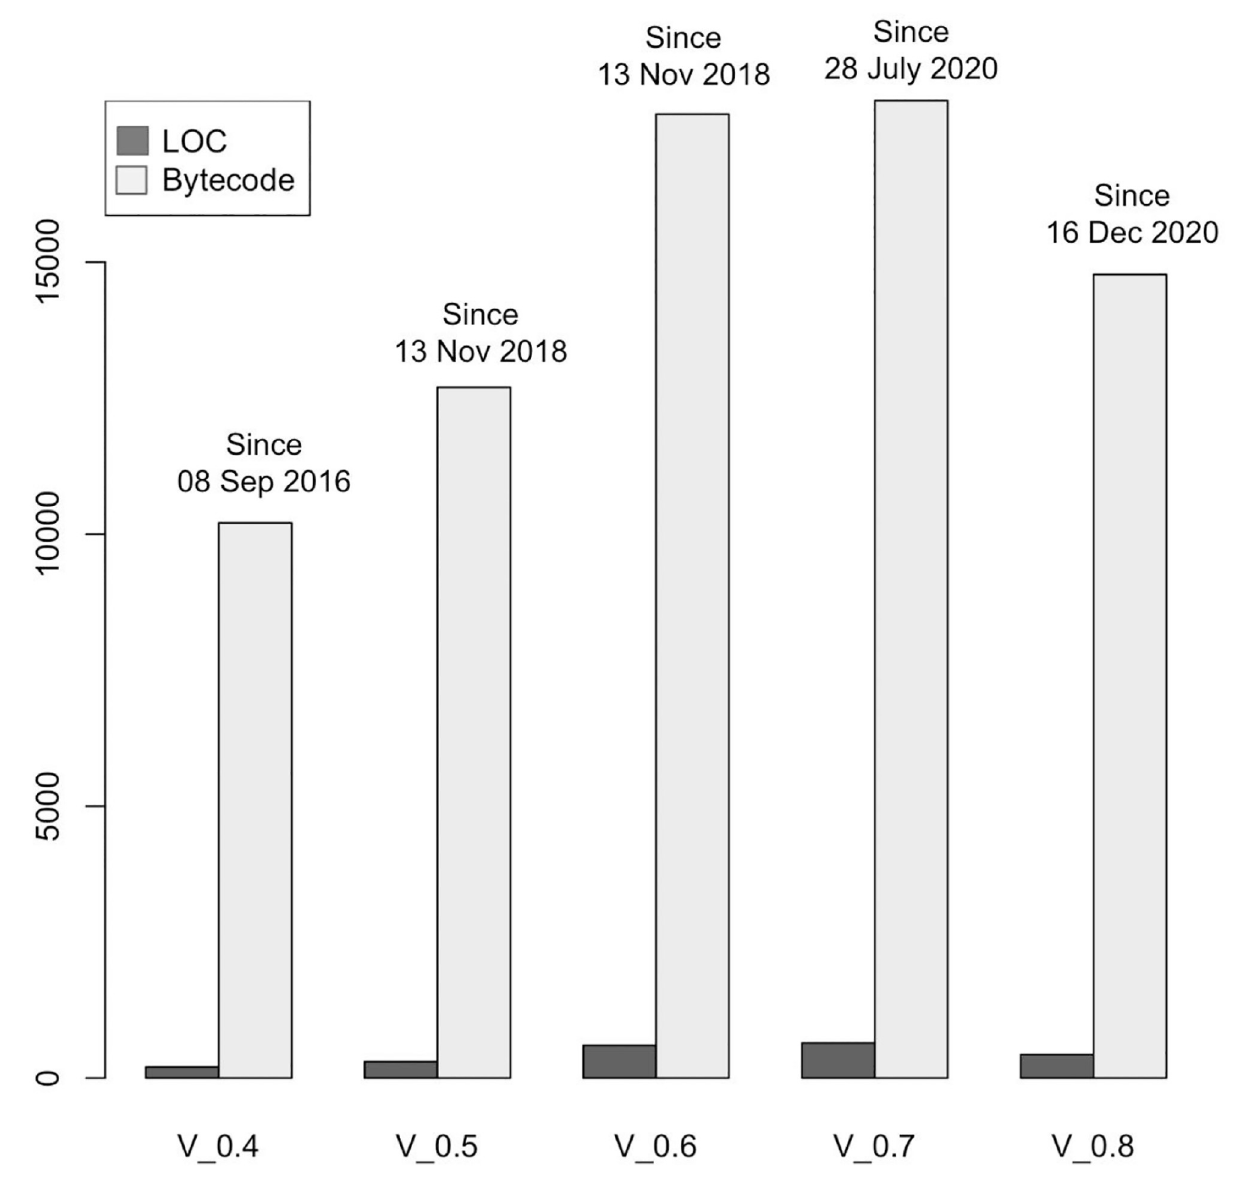
Fig 7. The average number of LOC and Bytecodes per Smart